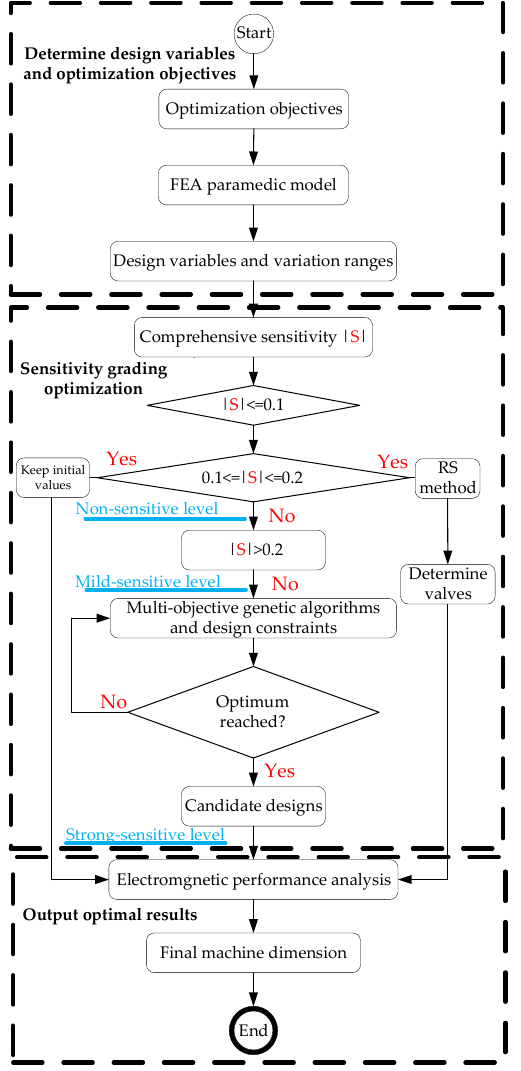
Figure 20. Sensitivity grading optimization flow chart [76].